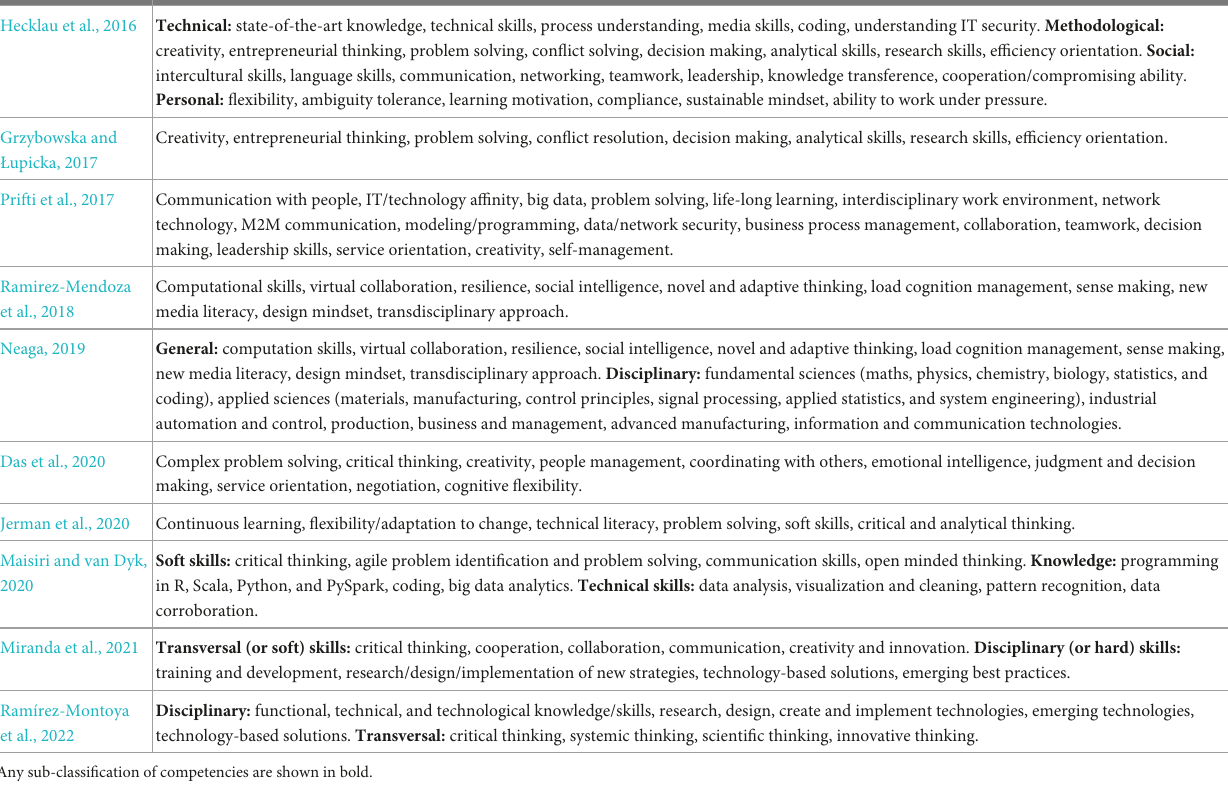
TABLE 3 A summary of some key prior literature review/bibliometric analyses, that attempt to understand, classify, and/or capture/map E.D. 4.0 to I.D. 4.0.